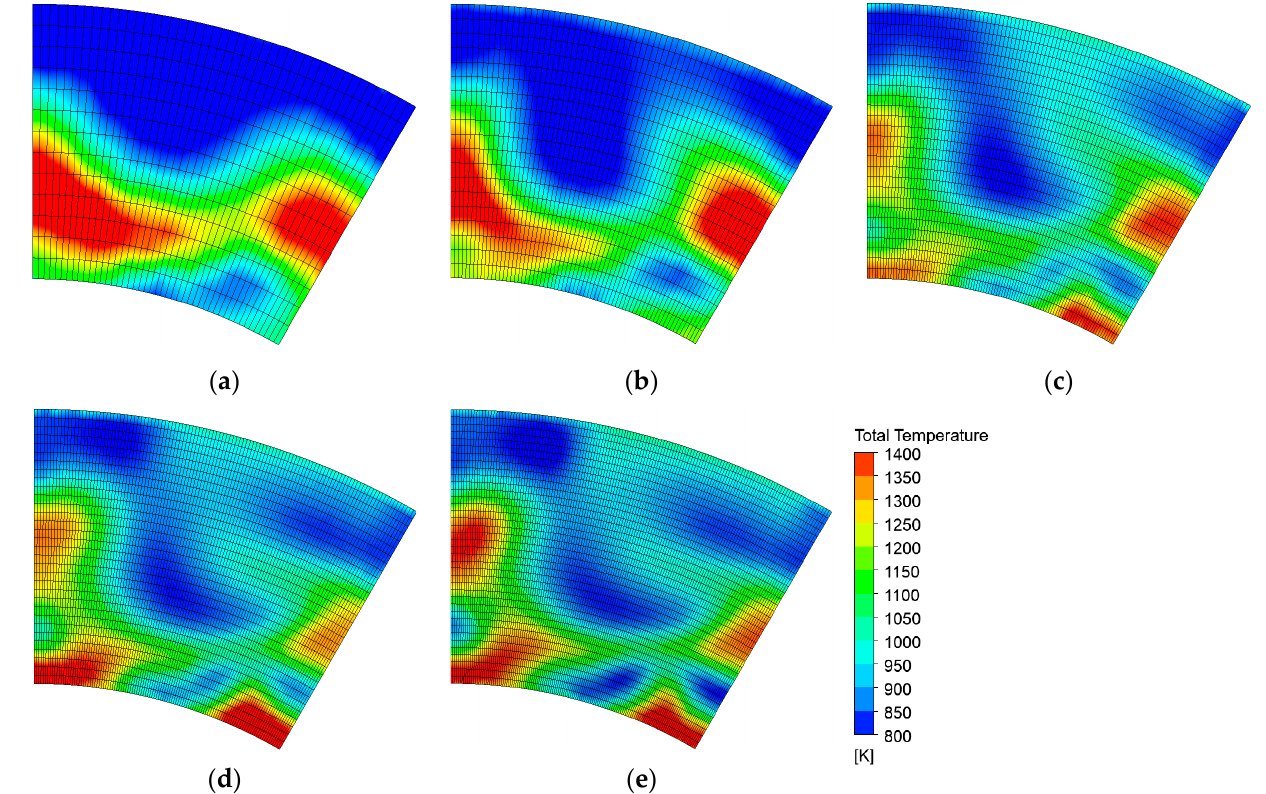
Figure 4. Combustor outlet total temperature contour of different mesh size configuration: ( a ) 0.8 M; ( b ) 2.1 M; ( c ) 3.3 M; ( d ) 4.5 M; ( e ) 6.2 M.